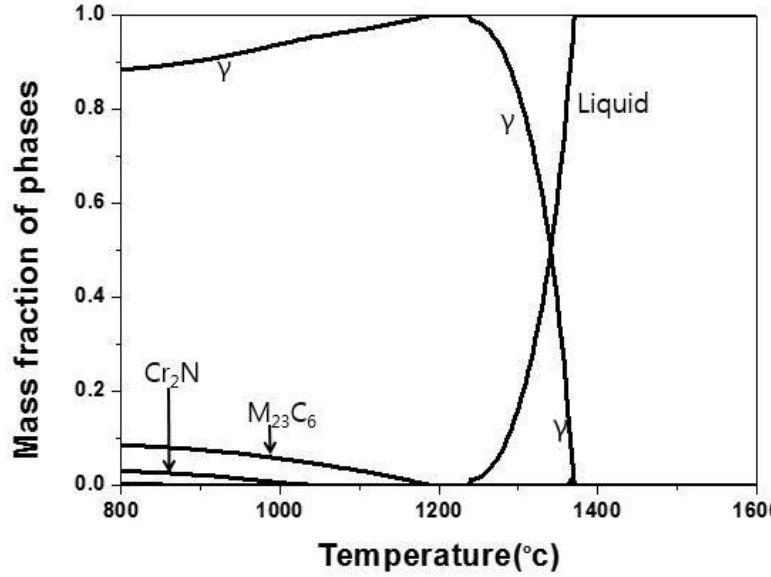
Figure 3. Computed mass fraction vs temperature diagram, showing the temperature range and mass fraction of ferrite, austenite γ , Cr 2 N, M 23 C 6 , and the liquid phase.